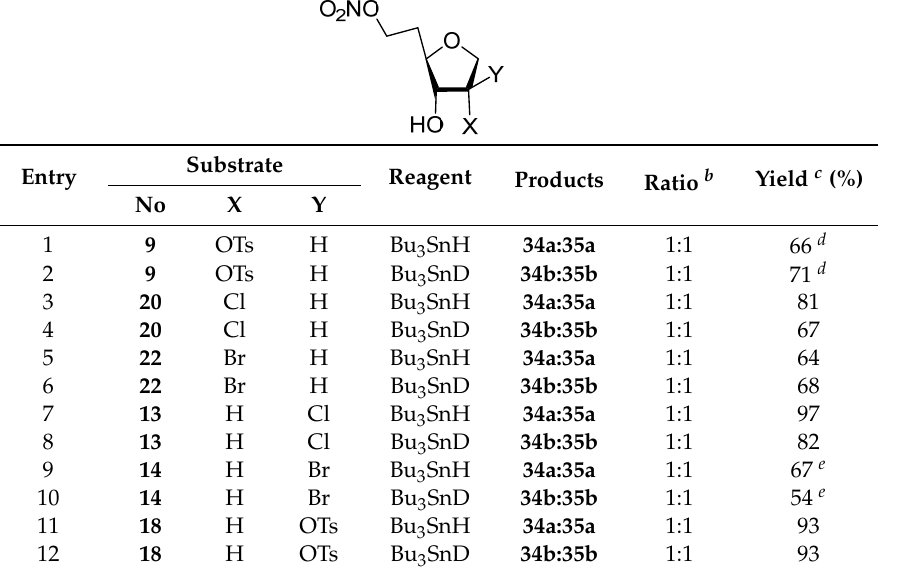
Table 1. Products from 6- O -nitro-1,4-anhydrohexitols a.